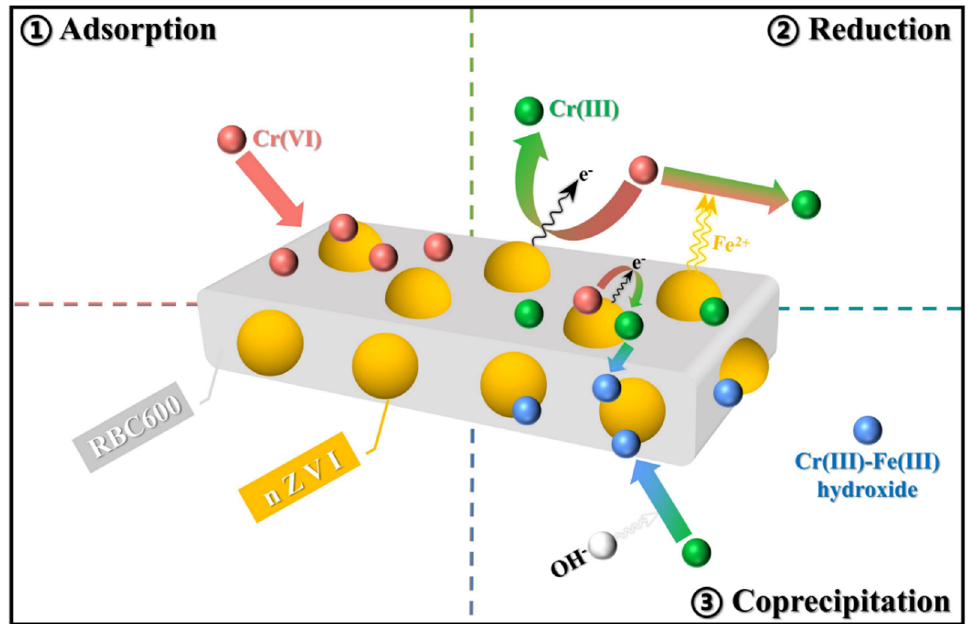
Figure 8. Proposed adsorption mechanisms of Cr(VI) by RBC600-nZVI.